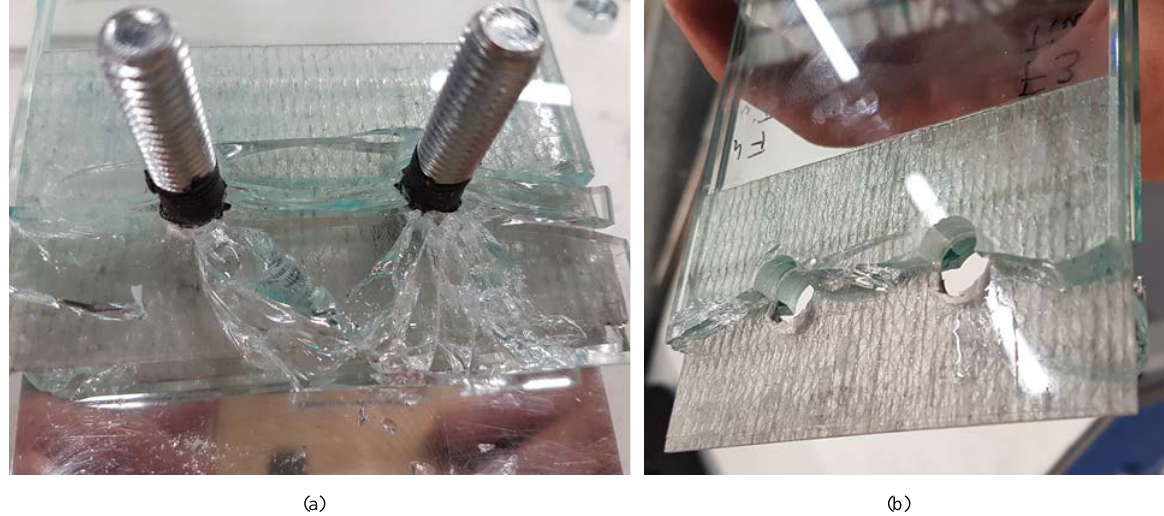
Fig. 7: Failure of glass in a reinforced annealed glass joint configuration, a) Glass fractured in the vicinity of the bolts , b) The GFRP strip remains intact although the glass has